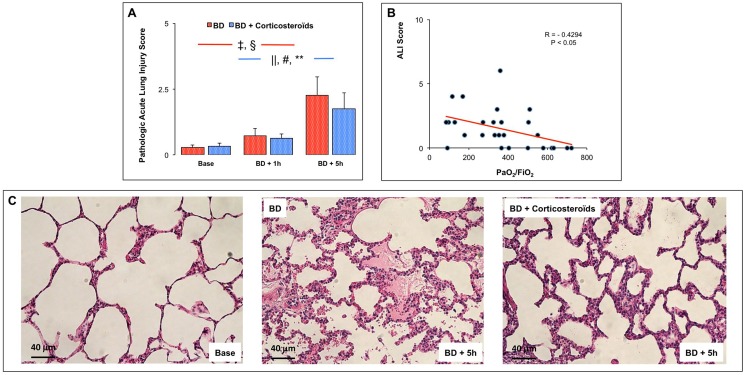
Characterization of acute lung injury (Panel A) at baseline, one (BD + 1 hour) and five (BD + 5 hours) hours after Cushing reflex in the placebo-pretreated brain death (BD group; n = 11; red bars) and the methylprednisolone-pretreated brain death (BD + Corticosteroids; n = 8; blue bars) groups. Panel B: Correlations between the ratio PaO2/FiO2 and ALI score. Panel C: Illustrative microscopic views (magnitude 200x) of hematoxylin-eosin stained lung sections at baseline and at 5 hours after Cushing reflex in the BD and the BD+Corticosteroids treated pigs. Values are expressed as mean ± SEM., ‡ p<0.05 BD + 1 hour versus BD + 5 hours, § p<0.05 Base versus BD + 5 hours in the BD group; || p<0.05 Base versus BD + 1 hour, # p<0.05 BD + 1 hour versus BD + 5 hours, ** p<0.05 Base versus BD + 5 hours in the BD + Corticosteroids group.